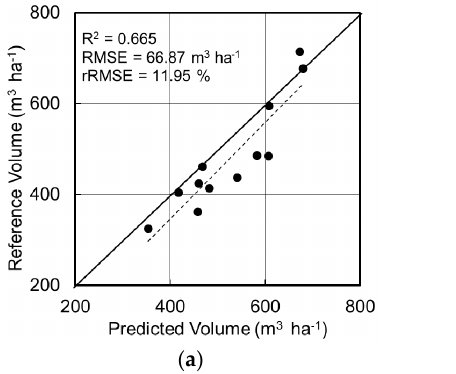
Figure 9. Model validation results from the regression analysis. Comparison of the reference and predicted stem volumes at each validation plots (indicated in Figure 6a) for ( a ) random forest regression (RFR) and ( b ) support vector regression (SVR). The figure shows the best result from the modelling. RFR = Model RFR18 ; SVR = Model SVR2 . The solid black line indicates the 1:1 line. The dotted line is the linear trend line between the predicted and reference volume just for the visual reference, and it does not represent the R 2 shown.